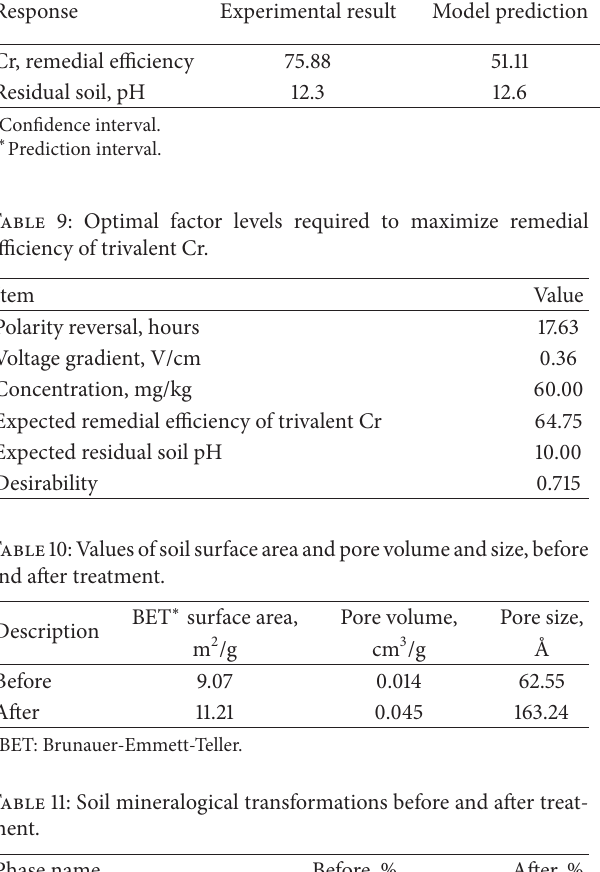
Table 8: Experimental validation of trivalent Cr remedial efficiency and soil pH using voltage gradient = 1V/cm; average concentration = 44.15 mg/kg; and polarity reversal rate = 0hr.